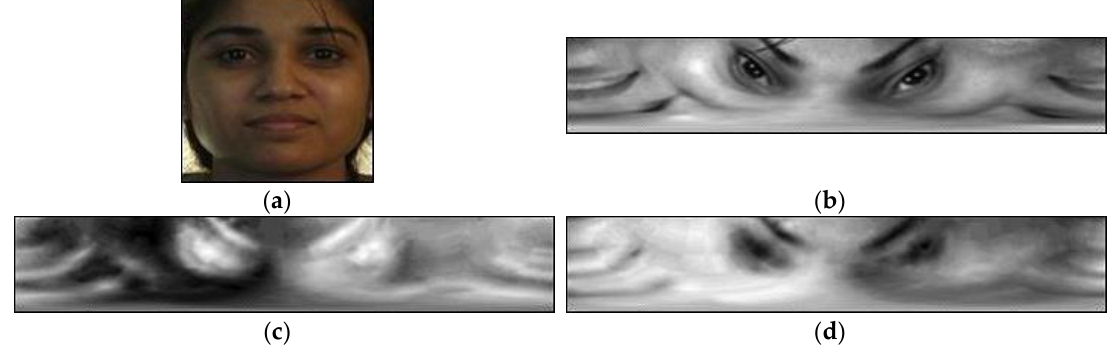
Figure 2. ( a ) RGB face image; ( b ) Y channel; ( c ) Cb channel; ( d ) Cr channel.